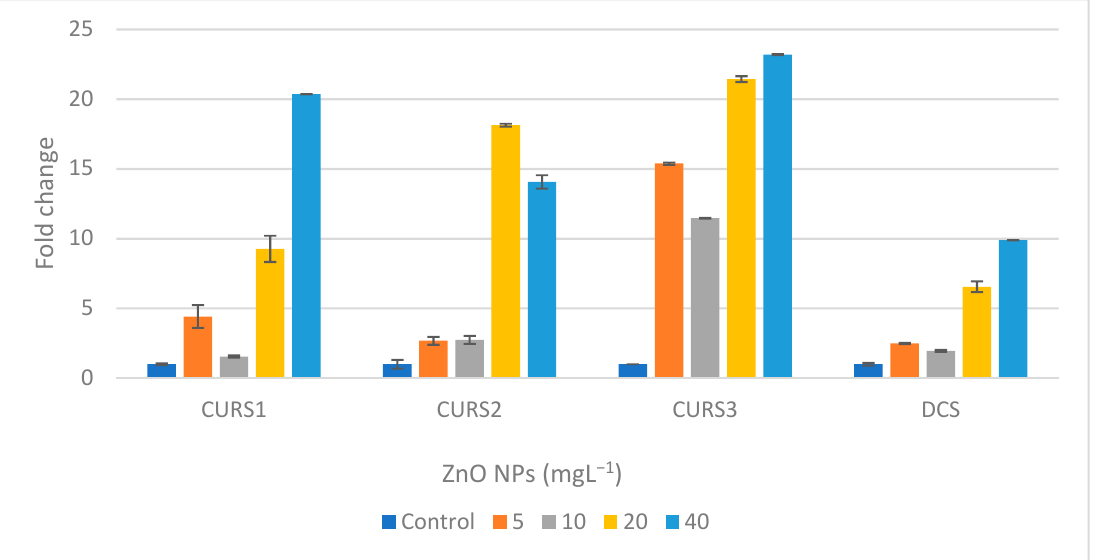
Figure 2. Expression patterns of curcuminoid synthase genes, CURS1 , CURS2 , CURS3 , and DCS , in C. longa rhizome from control and zinc oxide nanoparticles (ZnO NPs) (5, 10, 20, and 40 mgL − 1 ) treated plant. The Actin gene was used as an internal reference gene.